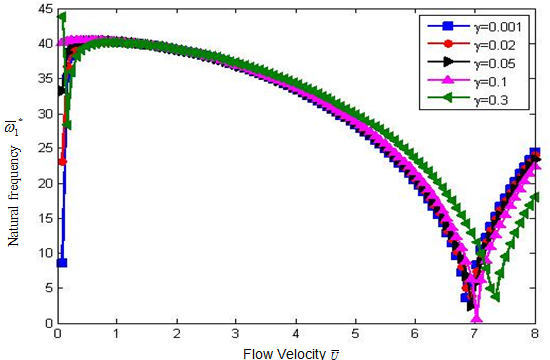
Figure 8. Absolute values of the transverse natural frequencies profile for the case R i = 0 . 41 m,L = 2 km,γ = 0 . 02 ,n = 1 ,δ 2 = 0 . 3721 ,χ = − 0 . 2